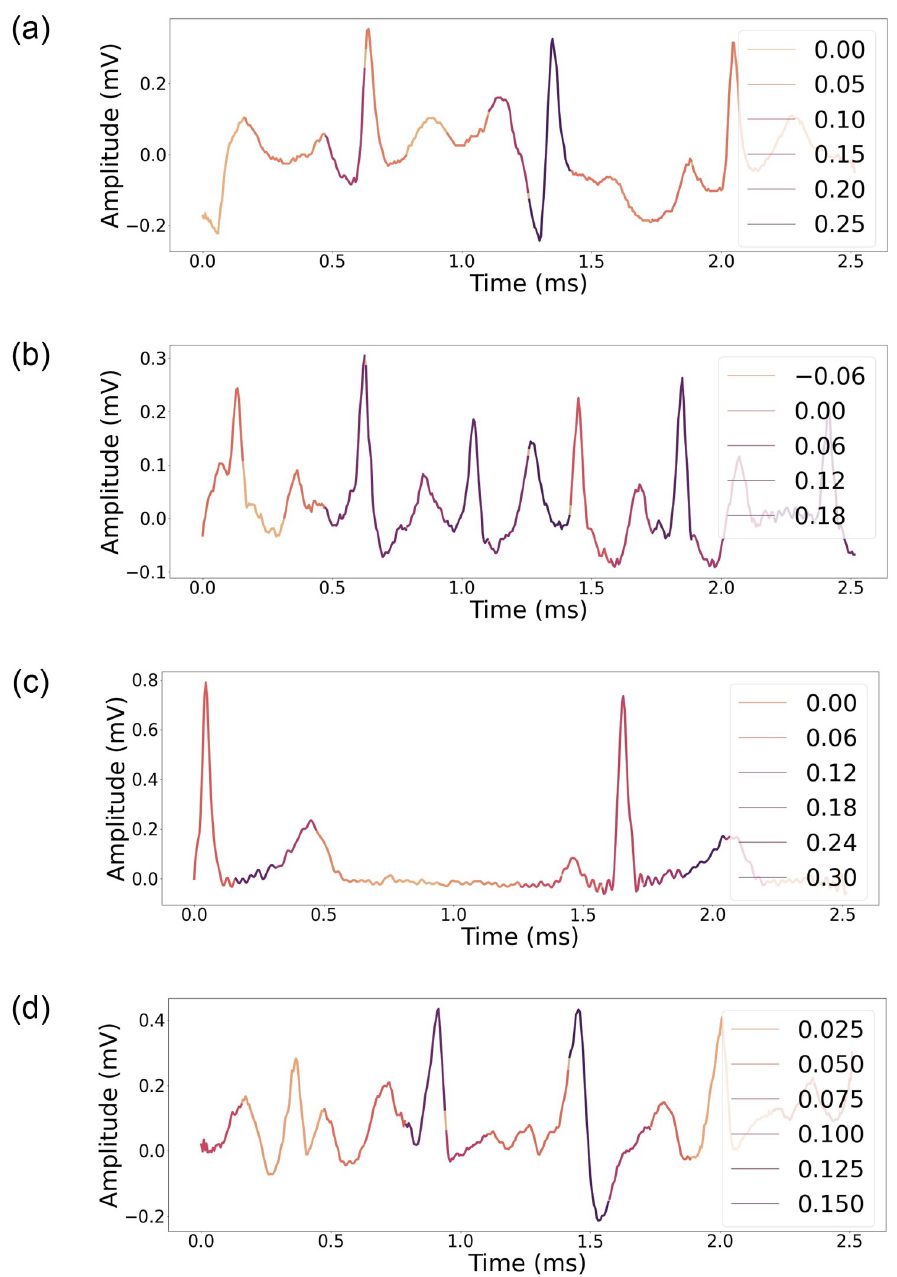
Fig 8. ( a, b ) Grad-CAM visualization of ECG image with COVID-19. ( c, d ) Grad-CAM visualization of ECG image with MI. Signal segments significant to the classifier are depicted in darker